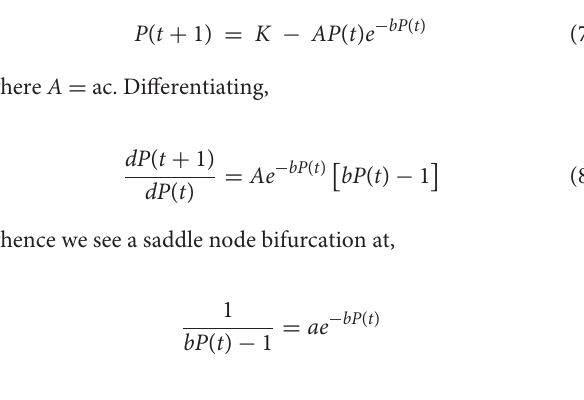
FIGURE 6 | Farmer’s planting participation [H(t) land devoted to tomato production] as a function of the current (planting time) price of tomatoes on the market (data reported in Vandermeer,